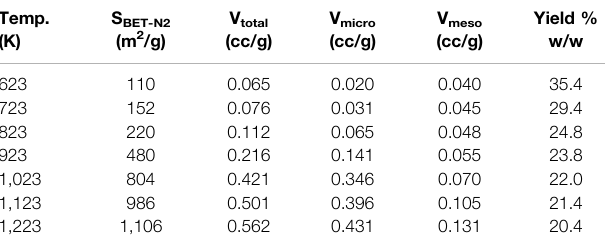
TABLE 6 | Effect of temperature on textural characteristics on sulfuric acid bamboo derived activated carbons (N 2 , 2 h, Xp (cid:2) 1). Temp.